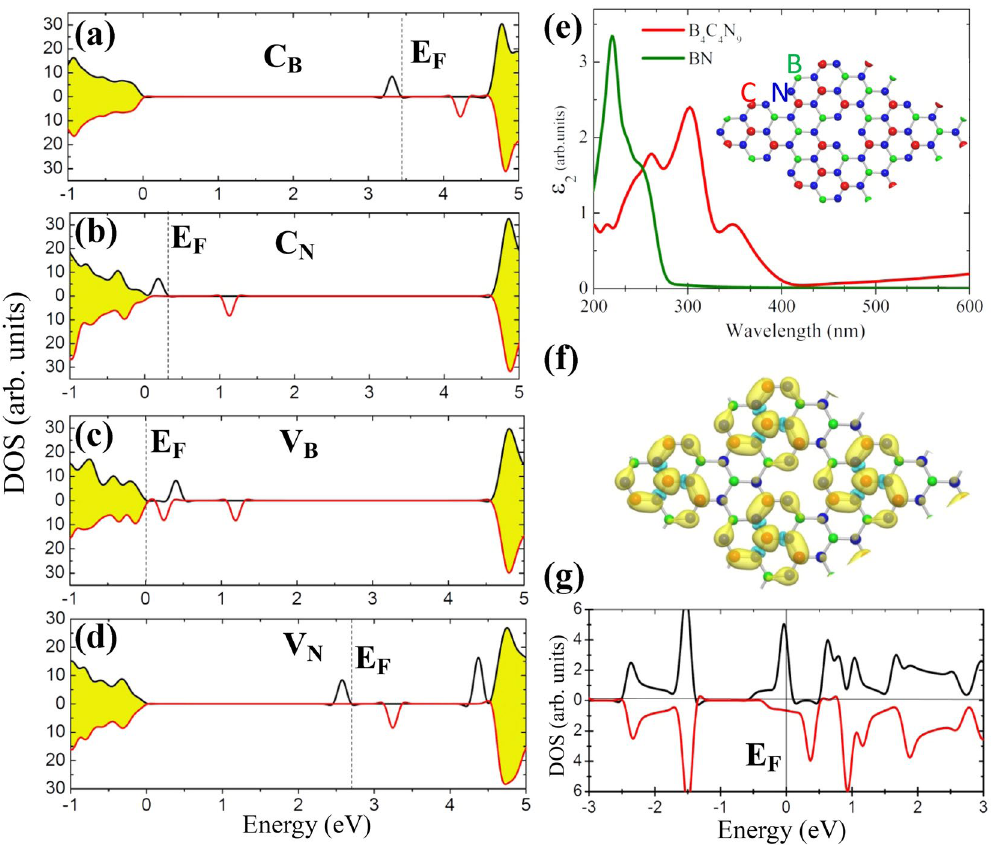
Figure 5. ( a – d ) Spin-resolved electron density of states (DOS) of BNNSs containing a C B , C N , V B , and V N defect, respectively. The shadow area represents the states of BNNSs. The dashed lines indicate the positions of Fermi level. ( e ) The imaginary part of dielectric function ε 2 ( ω ) which represents the light adsorption property calculated for pristine BNNSs and the C-doped BNNSs (B 4 C 4 N 9 ) shown in the inset of this figure. ( f ) The isosurfaces of the spin-polarized electron density ∆ ρ calculated from the difference between the electron densities of two spin channels: ∆ ρ = ρ↑ − ρ↓ . ( g ) The spin-resolved DOS of the B 4 C 4 N 9 nanosheet. The energy at the Fermi level was set to